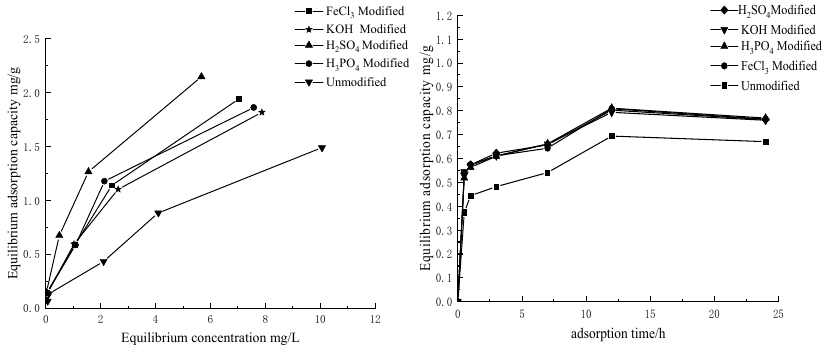
Figure 3. Adsorption isotherm curve ( left ) and adsorption kinetics curve ( right ).